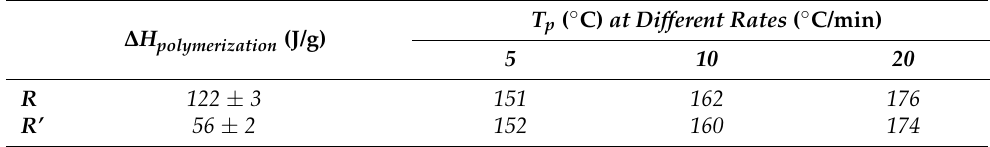
Table 6. Polymerization enthalpy and curing peak temperature of R and R’.